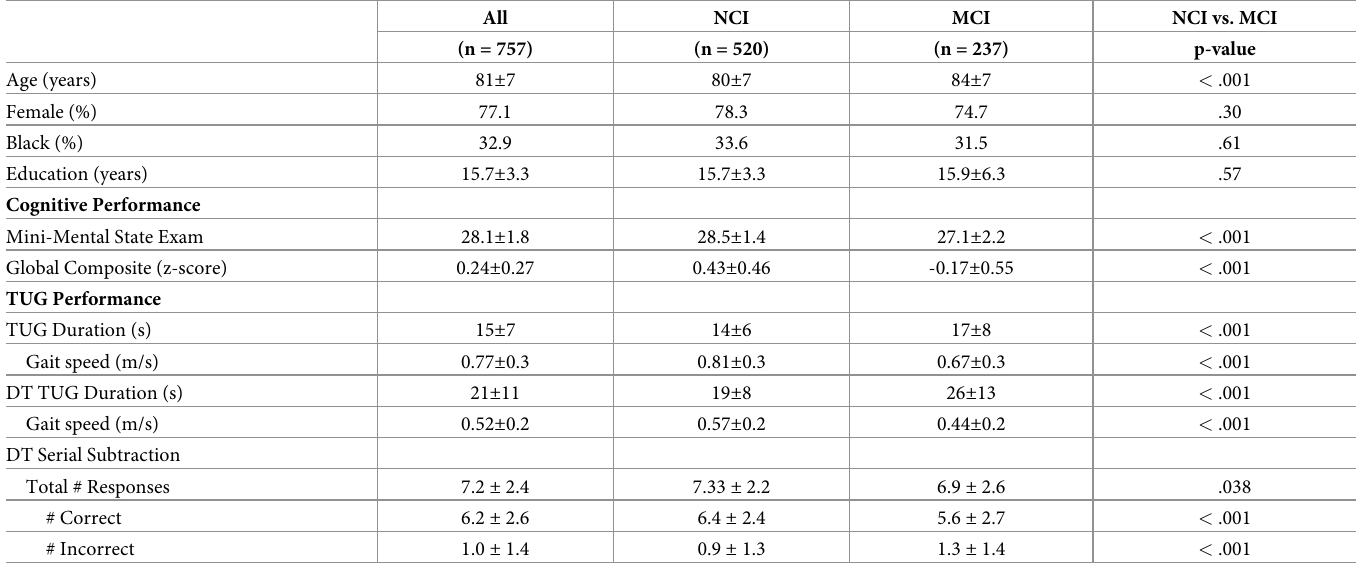
Table 1. Participant, cognitive, and overall TUG performance